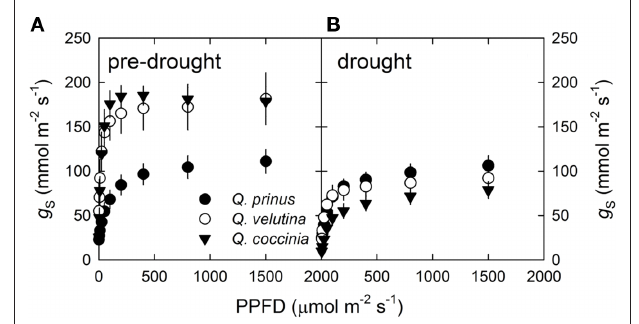
Figure 1 | Stomatal conductance ( g ) to light (PPFD) response curves S measured with the LiCOr 6400 for Quercus prinus (filled circle), Q. velutina (open circle), and Q coccinea (filled triangle) (A) before the onset of drought in June 2006 and (B) during drought in August of 2006. Error bars are the SE around